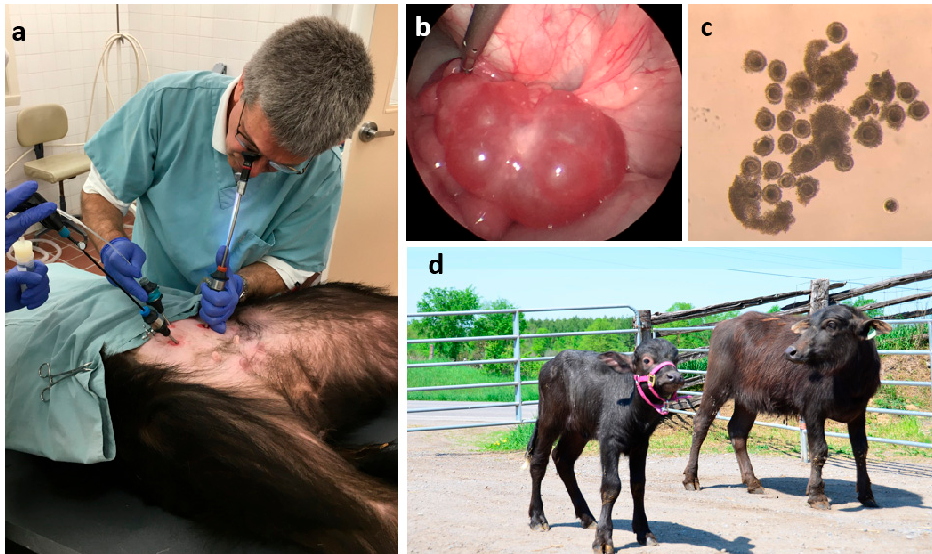
Figure 2. LOPU in buffalo calf: ( a ) the procedure showing port insertion and all instruments in place; ( b ) endoscopic view of hormonally stimulated ovary ready for LOPU with multiple follicles of >5 mm; ( c ) cumulus–oocyte complex recovered from buffalo calf; ( d ) “Jeanette” (left), the first buffalo born in North America by applying LOPU-in vitro embryo production (IVEP) in a prepubertal donor is pictured here with her genetic mom “Quiche” (right), who was only 4 months of age when she donated the oocytes.